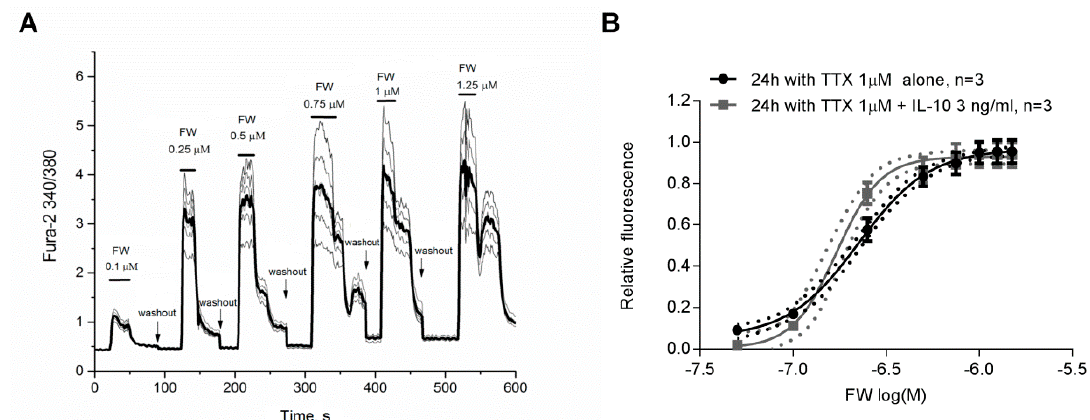
Figure 4. Co-treatment with IL-10 increases dose response action of 5-Fluorowillardiine (FW) on Ca 2 + signals in cultured hippocampal neurons. ( A ) Representative trace showing [Ca 2 + ] i responses in Fura-2 loaded neurons induced with application of FW at gradually increasing concentrations. Solid black line represents averaged signal from a group of neurons. Ca 2 + signals from individual neurons are represented by the gray thin lines. ( B ) Dose-dependent curves of FW action on Ca 2 + signals in neurons treated with 1 µ M of TTX for 24 h (black curve) or neurons treated with a combination of 1 µ M TTX and 3 ng / mL of IL-10 for 2 h (gray curve).